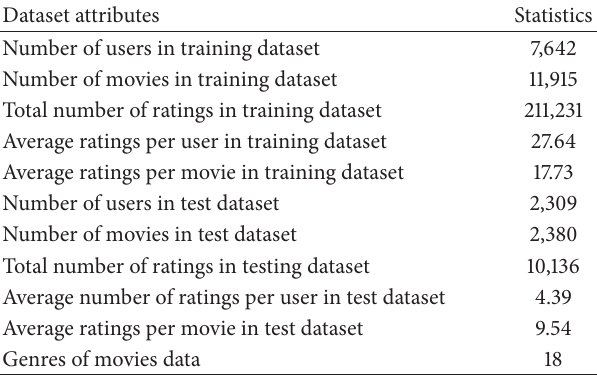
Table 1: Statistics of Yahoo! Movies dataset.